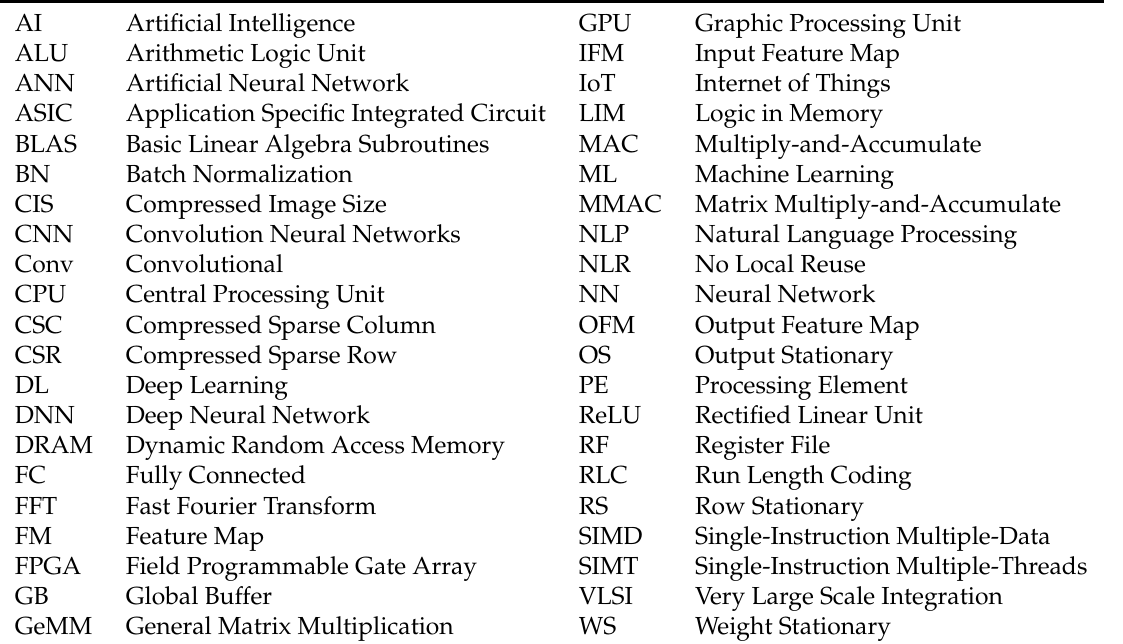
Table A1. List of